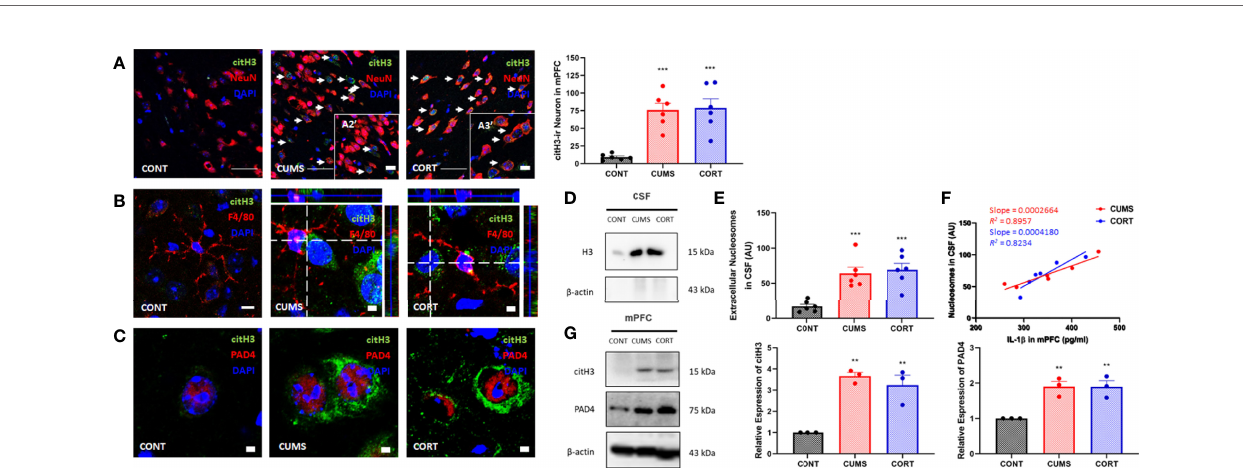
FIGURE 3 | Chronic stress induced extracellular histones release and extracellular trap formation in mPFC. (A) Representative immuno fl uorescence images showing the citH3 + and NeuN + in CONT, CUMS, and CORT groups were presented, and citH3-ir neurons in mPFC was analyzed (two-way ANOVA with Tukey ’ s post hoc test post hoc , *** P < 0.001, compared with CONT. Two replica for n = 3). Scale bars: 20× and, 40×. (B) Representative immuno fl uorescence images showing the relationship of F4/80 + microglia and citH3 + cells in CONT, CUMS, and CORT groups were presented. Scale bar: 126×. (C) Representative immuno fl uorescence images showing the relationship of citH3 and PAD4 in CONT, CUMS, and CORT groups were presented. Scale bar: 126×. (D) Representative Western blots showing extracellular histone H3 in CSF. (E) Concentration of nucleosomes in CSF was analyzed (two-way ANOVA with Tukey ’ s post hoc test post hoc , *** P < 0.001, compared with CONT; n = 6).